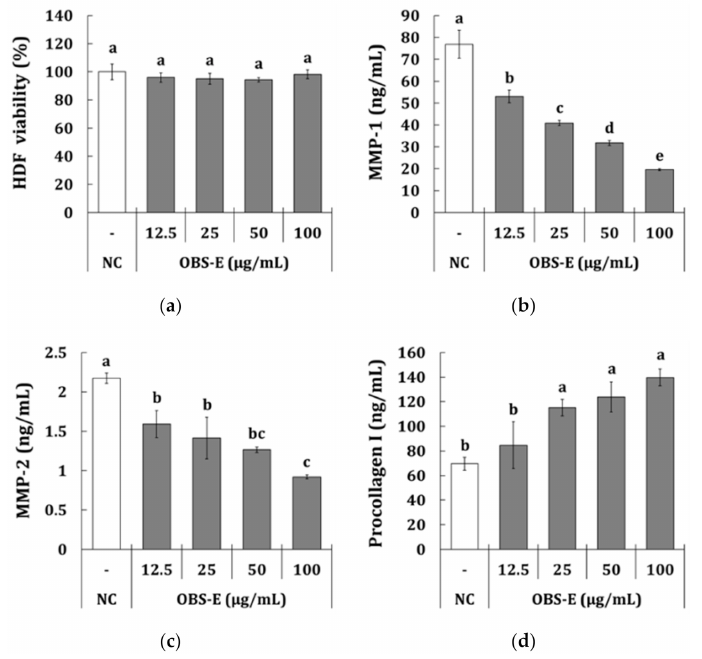
Figure 1. Anti-wrinkle activity of OBS-E in human dermal fibroblasts (HDF). ( a ) Cell viability, ( b ) MMP-1 inhibition, ( c ) MMP-2 inhibition, ( d ) procollagen type I production. Only medium was used as a negative control (NC). The different superscripts indicate significant differences among groups as analyzed using the Tukey’s t -test ( p < 0.05). MMP, matrix